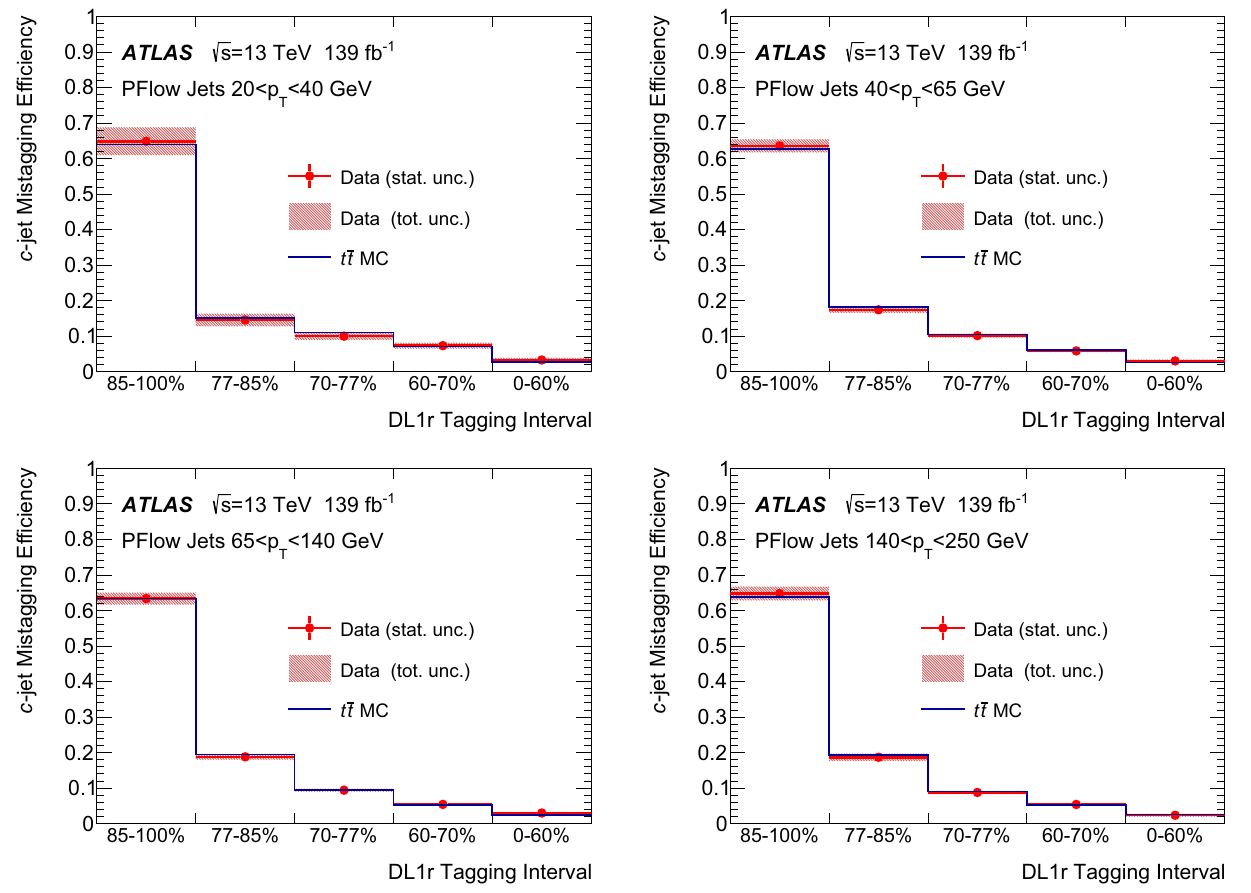
Fig. 4 The c -jet pseudo-continuous mistagging efficiencies for particle-flow jets shown as red points as a function of tagging interval for the four jet- p T ranges. Included in the plots are the corresponding MC efficiencies using the Pythia 8+ EvtGen fragmentation model